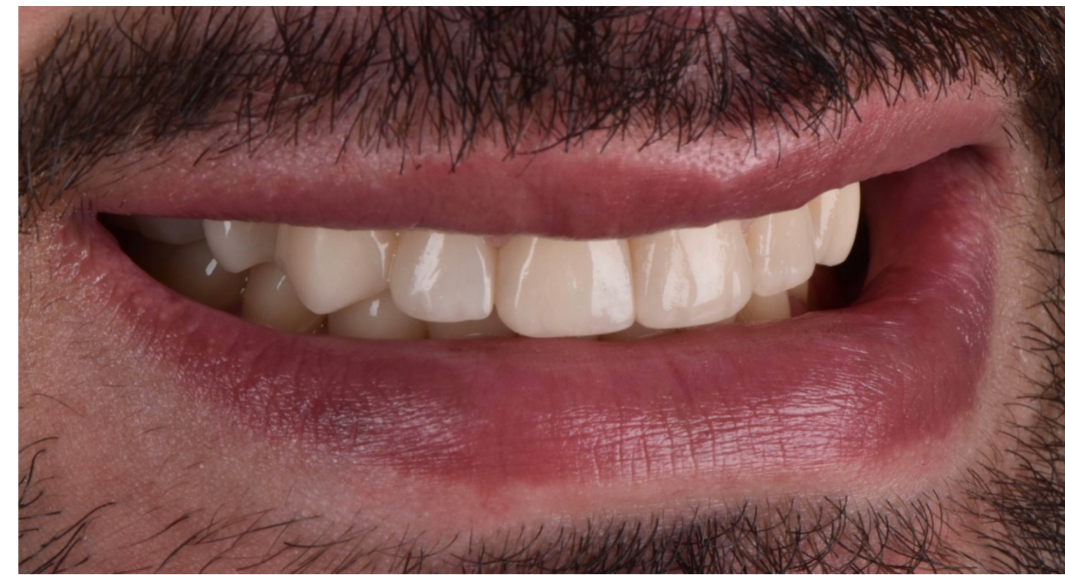
Figure 28. Final extraoral smile picture